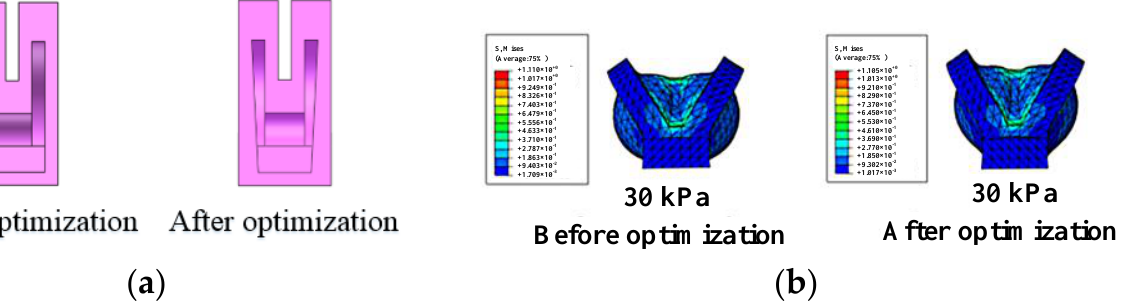
Figure 10. Optimization of the four-finger rotating. ( a ) Structural optimization and ( b ) optimization simulation comparison